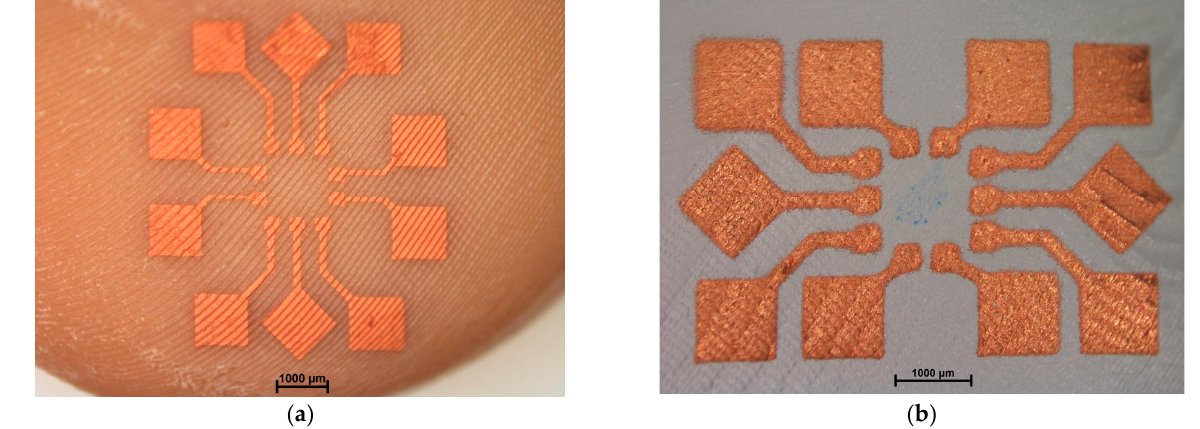
Figure 6. Aerosol jet printed Ag structures (ink: Sicrys I30 EG-1) on 2D test substrate after electroless copper plating on Fototec DLP A. Test layout with La, Lb and Lc ( a ) and Ma and Mb ( b ) structures (La: 3 mm line, Lb: 3 parallel 3 mm lines with a distance of 30 µm between each other, Lc: 5 parallel 3mm lines with a distance of 30 µm between each other, Ma: 35 mm meander, Mb: 35 mm meander consisting of 3 parallel lines with a distance of 30 µm between each other).